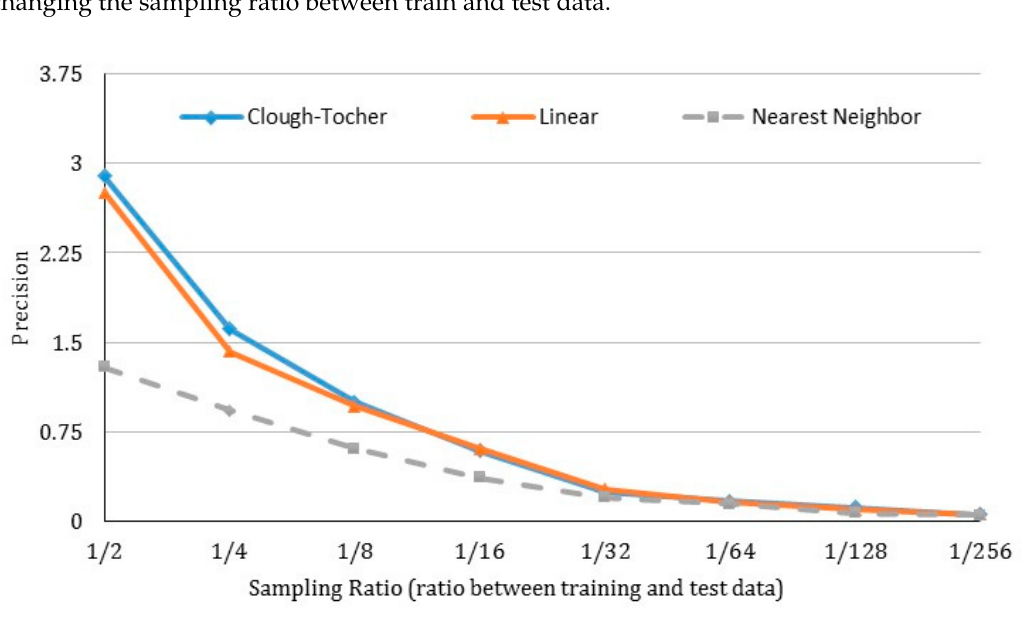
Figure 11. A comparison of accuracy across different interpolation methods, as the number of training data used for interpolation decreases.